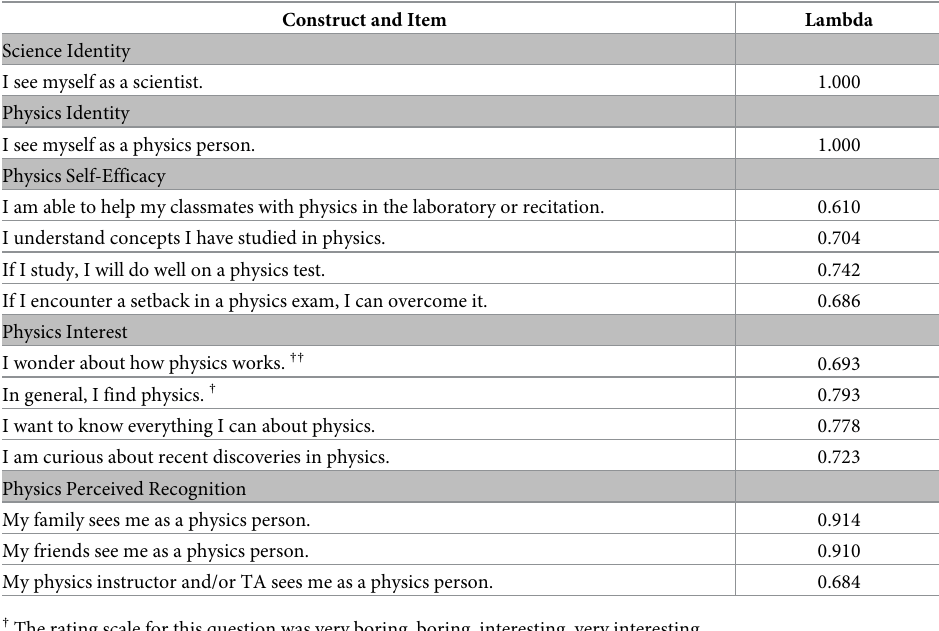
Table 1. Survey questions for each of the motivational constructs along with factor loadings (lambda) from the Confirmatory Factor Analysis (CFA) result for all students (N = 873). The rating scale for most of the self-efficacy and interest questions was NO! no yes YES! while the rating scale for the physics identity and perceived recognition questions was strongly disagree, disagree, agree, strongly agree. All p -values (showing statistical significance for each factor loading) are < 0.001.